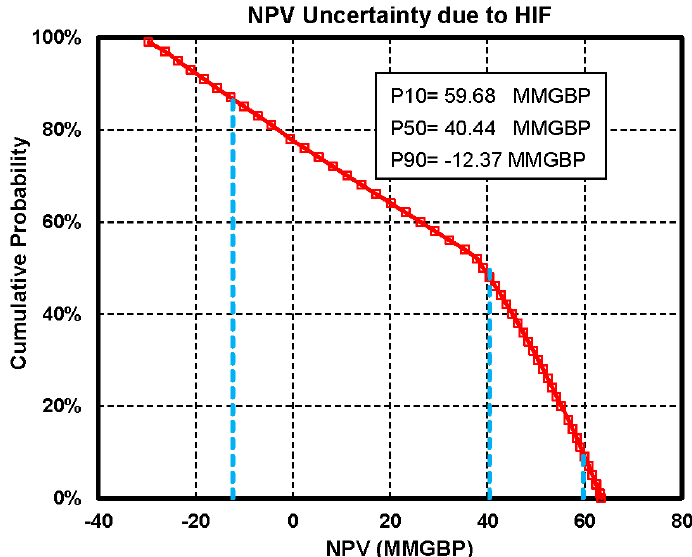
Figure 7. Cumulative probability distribution of NPV.